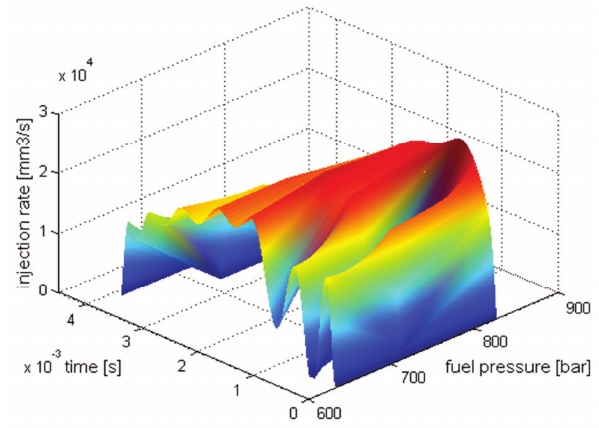
Fig. 5. Changes in parameters and forms of injection of the doses with constant value (second measuring